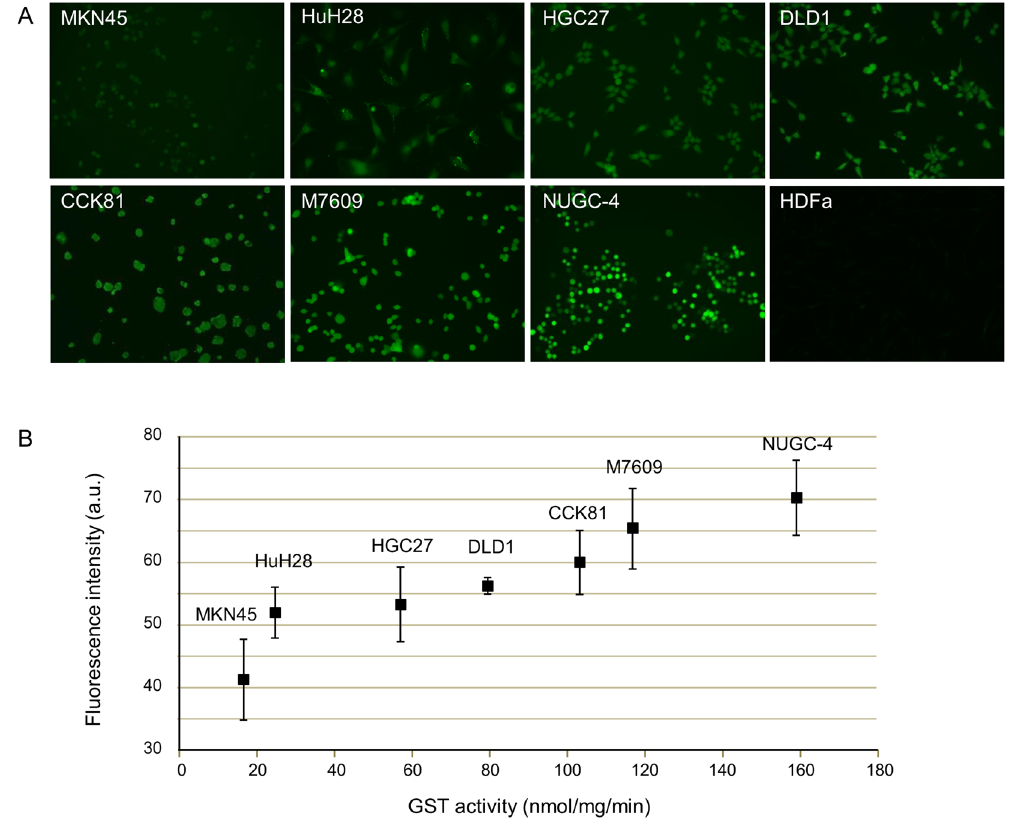
Figure 3. Correlation between GST activity and fluorescence intensity in various cancer cell lines. ( A ) Seven cancer cell lines (MKN45, HuH-28, HGC27, DLD1, CCK81, M7609, and NUGC-4) were incubated with DNAT-Me at 10 μ M for 10 min and observed under fluorescence microscopy with excitation at 488 nm. Fluorescence intensity per cell in each cell line was quantitated using software provided by the manufacturer, as described in Materials and Methods. A primary normal adult human dermal fibroblast line (HDFa) was used as a negative control. ( B ) The cytosolic fraction was extracted from each cell line, and GST activity was measured using 1-chloro-2,4- dinitrobenzene and glutathione as